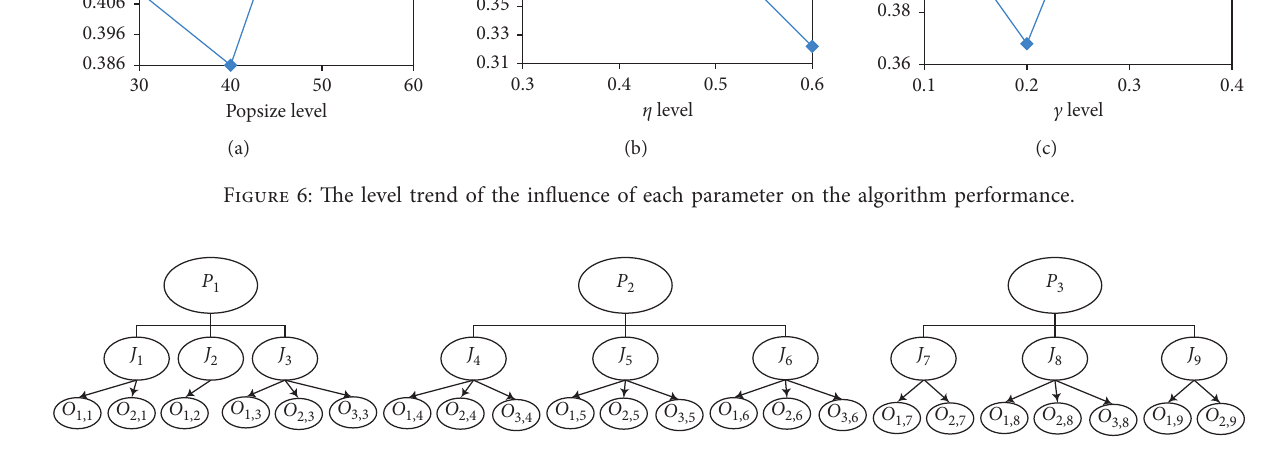
Figure 7: The product composition of the problem scale of (3_3_2). Table 4: Data at each stage of the problem scale of (3_3_2).